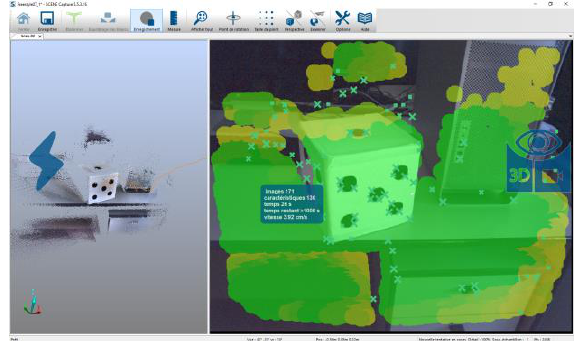
Figure 2. Screenshot from Scene Capture software during an